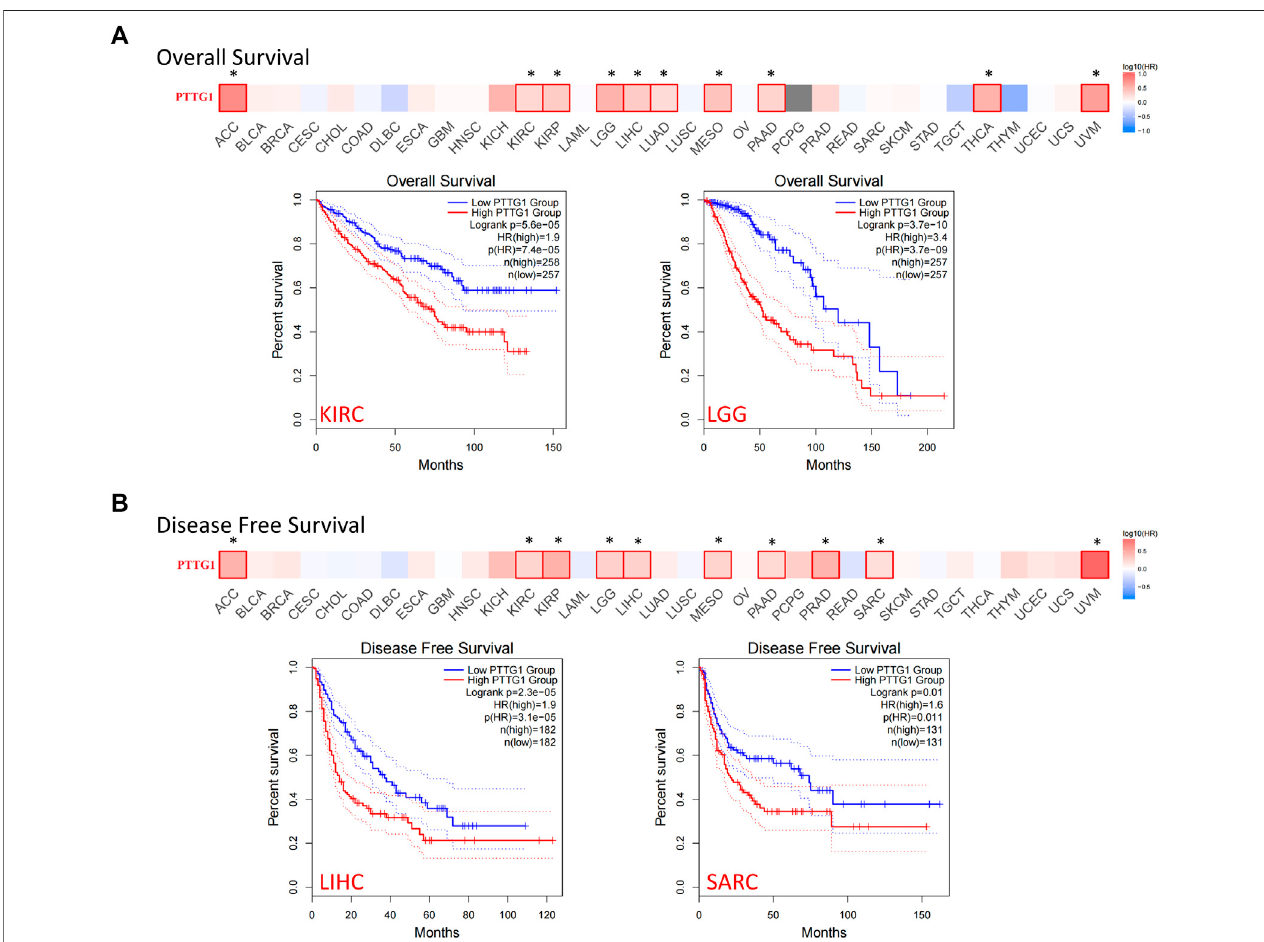
FIGURE 5 | The correlation between PTTG1 expression and survival prognosis of different tumor based on TCGA database. (A) The correlation between expression and overall survival (OS) in different tumors. (B) The correlation between PTTG1 expression and disease-free survival (DFS) in different tumors. The survival maps and Kaplan – Meier curves of two typical tumors were also shown. Dotted lines: 95% con fi dence interval. * p < 0.05.